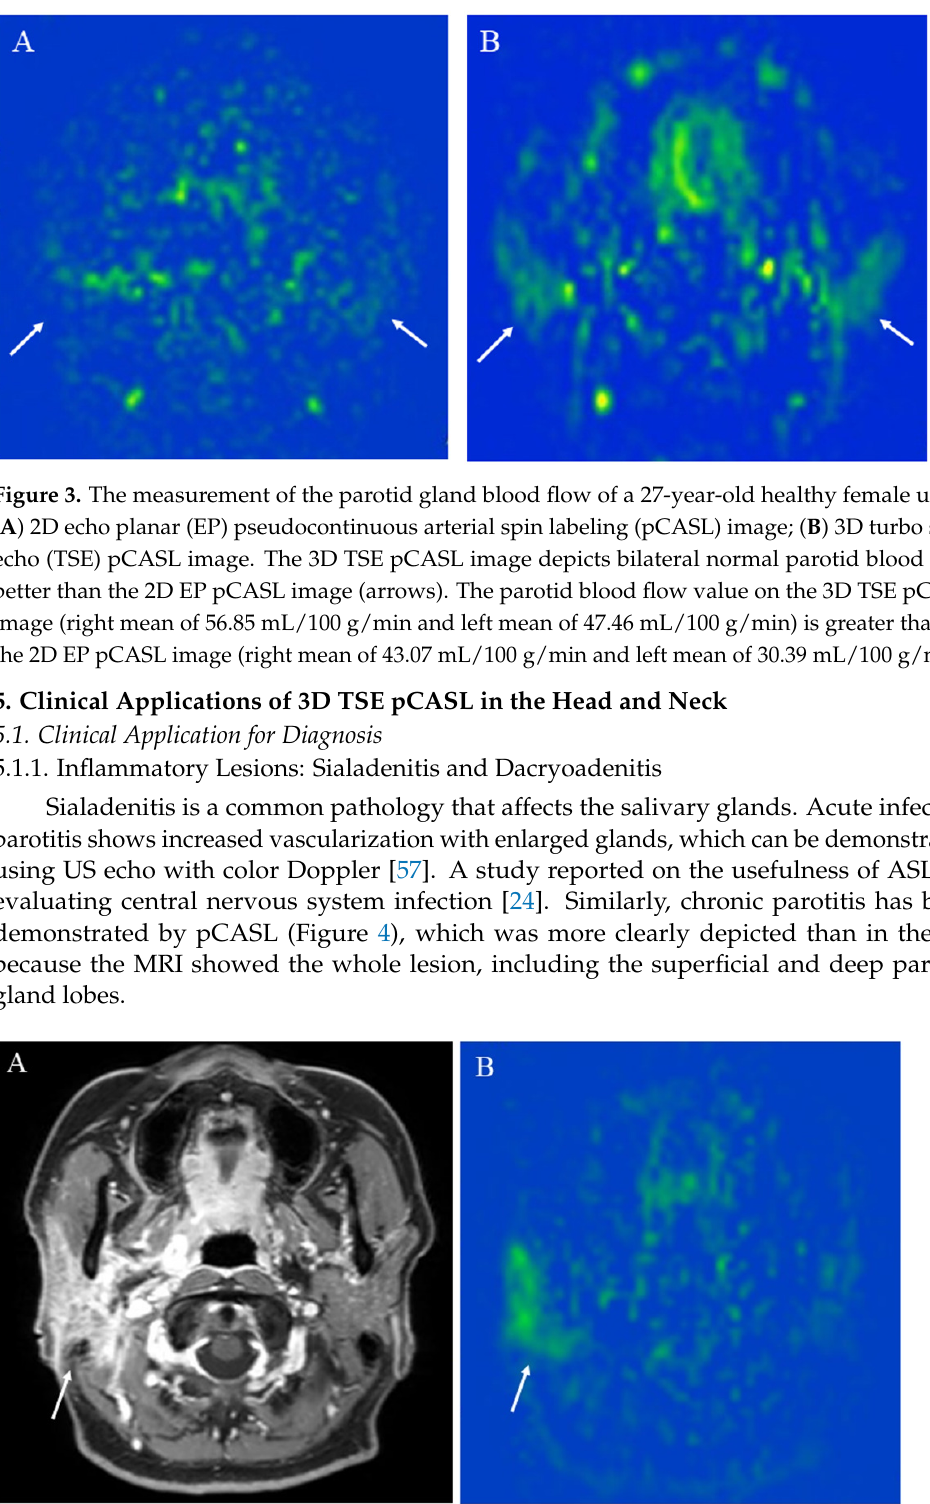
Figure 5. A 43-year-old female with immunoglobulin G4-related disease that involves the bilateral lacrimal gland: ( A ) Short tau inversion recovery (STIR) shows bilaterally enlarged lacrimal glands